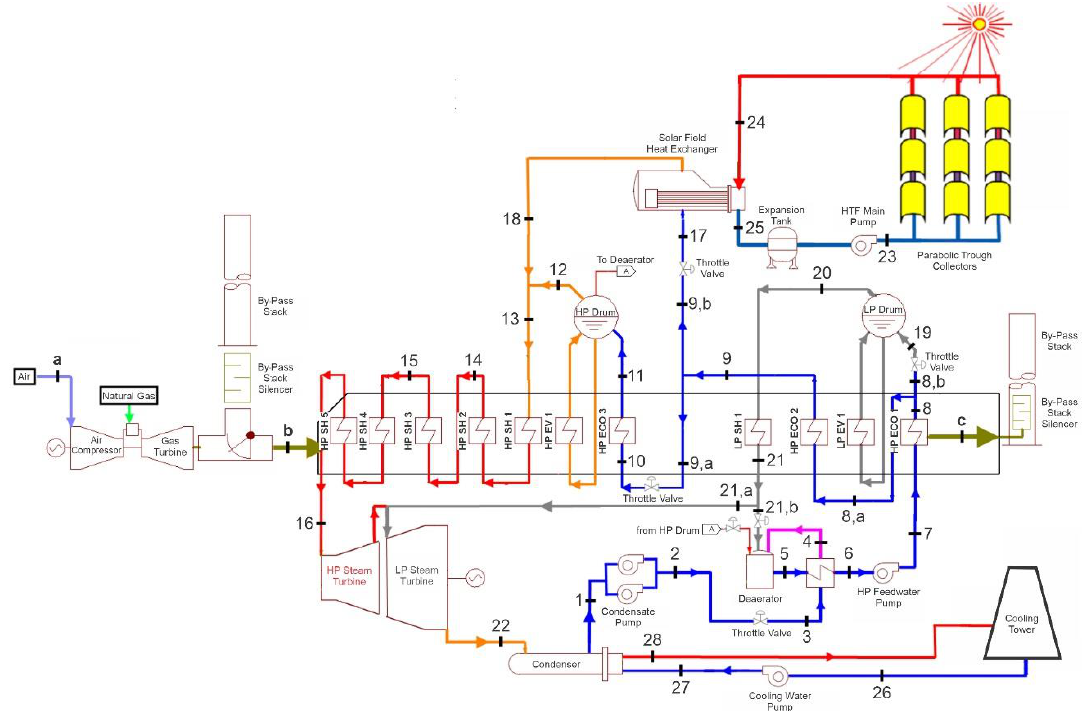
Figure 1. A flow diagram of the integrated solar combined cycle (ISCC) power plant in Kureimat with state points illustration.